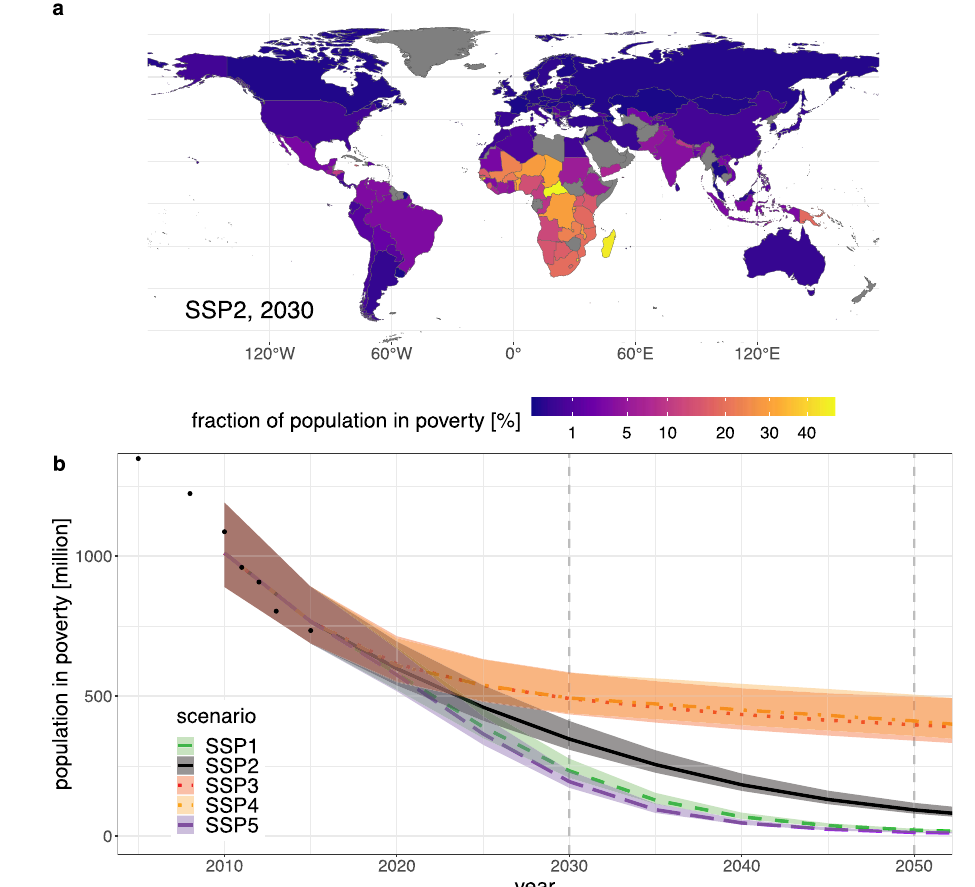
Fig. 1 National and global poverty trends in reference scenarios with neither climate impacts nor climate policies. a Projections for national poverty rates in an SSP2 scenario in 2030. For countries that are greyed out in the map, no data was available to calibrate the model for poverty outcomes. b Global poverty headcount in the different SSP reference scenarios. While SSP3 and SSP4 are very similar in the global trend, they differ in national and regional poverty projections. The solid/dashed/dotted lines indicate the central projection of our model for the respective SSP scenario. The shaded bands are the 68% prediction intervals; uncertainties are calculated from the regression model for the logit-transformed country-level poverty rates, and propagated to the global poverty headcount (see Section ‘ Projecting poverty headcounts and uncertainties ’ in Methods). Recent historical values 73 are shown with black